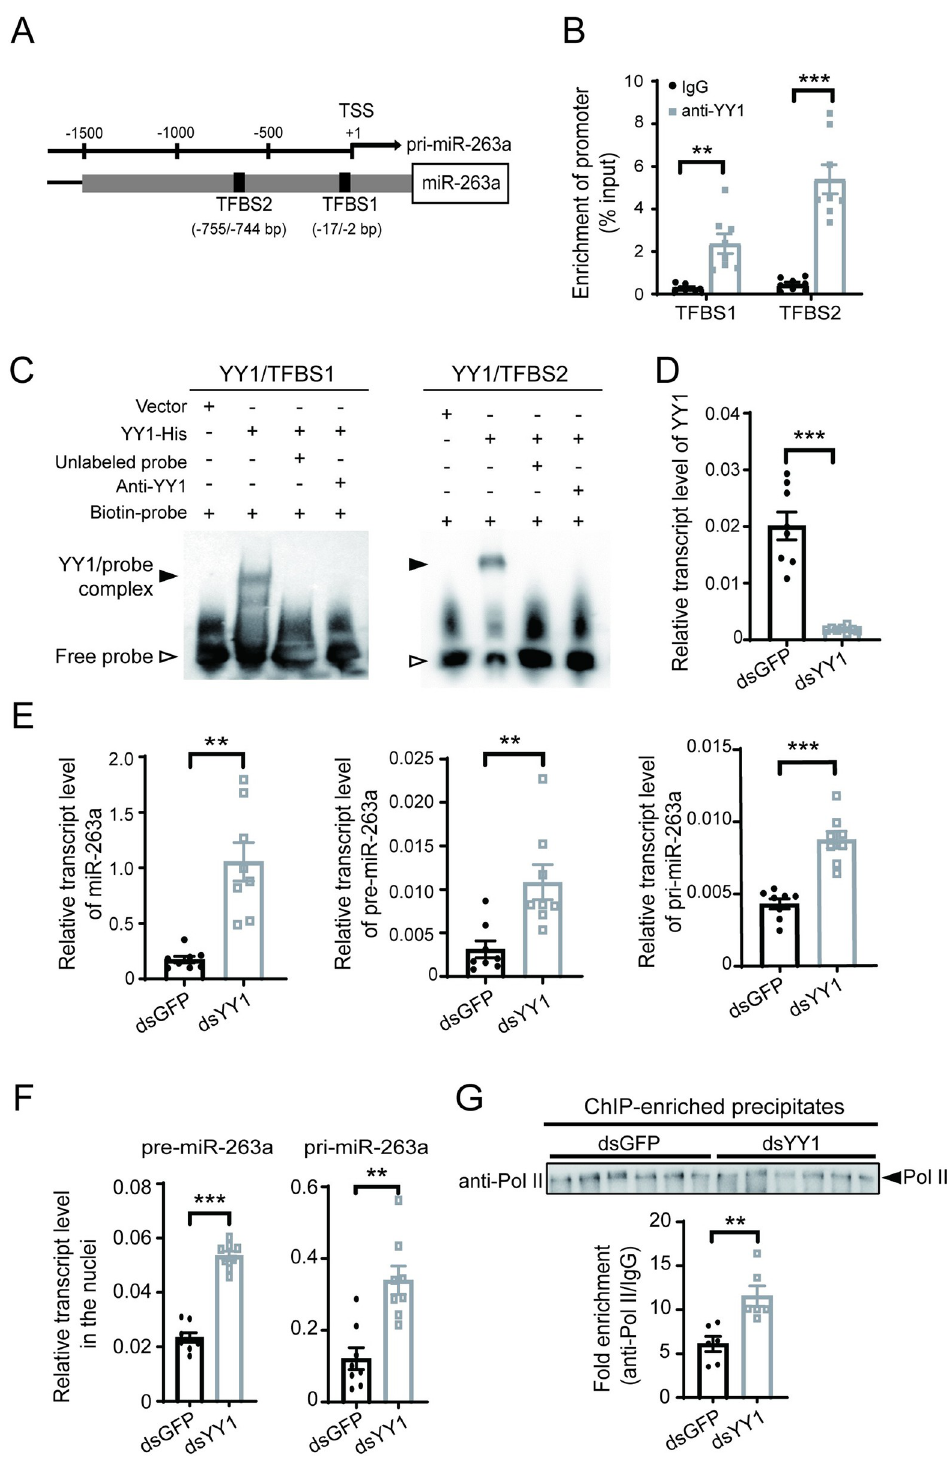
Fig 2. Transcription factor YY1 inhibits miR-263a transcription. (A) Schematic diagram showing two putative YY1 binding sites, TFBS1 and TFBS2 (black rectangles), in the promoter region of miR-263a. The transcription start site (TSS) is designated position +1. pri-miR-263a, primary miR-263a. (B) Relative enrichment of the two binding sites of YY1 measured by ChIP-qPCR (n = 8). IgG was used as the negative control. (C) EMSA assay on the binding of recombinant YY1-His to the DNA sequences containing TFBS1 (left image) or TFBS2 (right image) using the biotin-